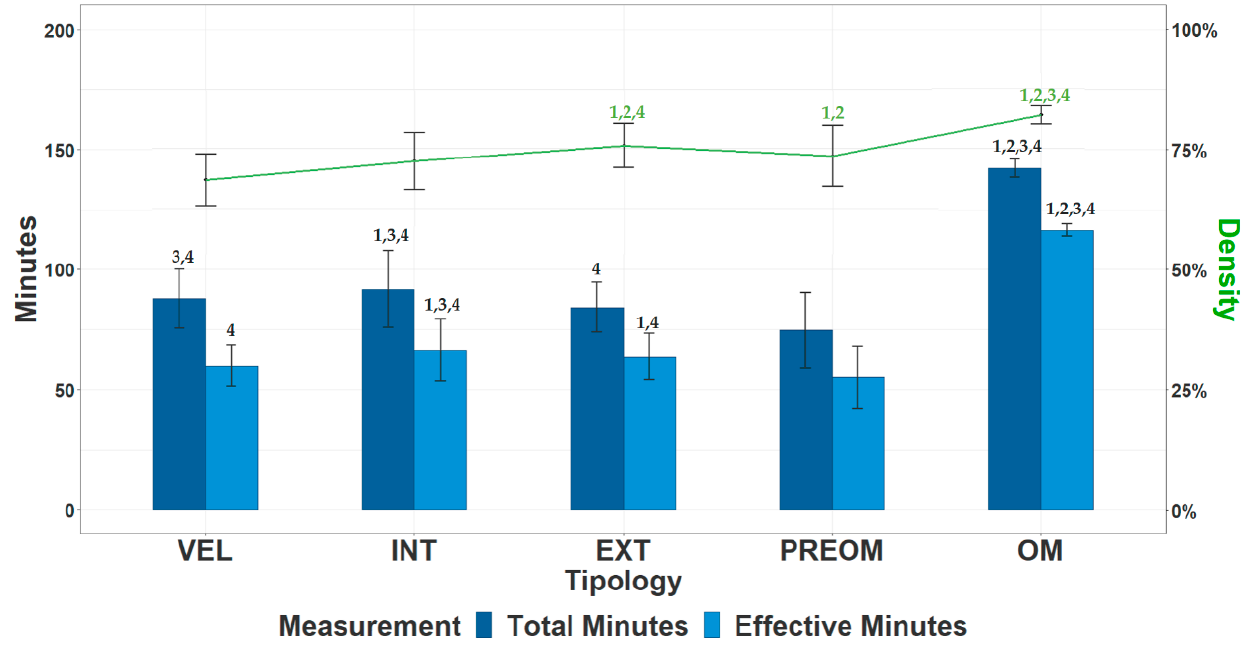
Figure 1. Total duration (min, in dark blue), effective duration (min, in light blue), and density (effective/total, %, in green) of the sessions. Note: VEL is velocity day, INT is intensity or strength day, EXT is extensity or endurance day, PREOM is previous day to match day, OM is official match day. Significant differences ( p < 0.05) are represented: 1 is higher than VEL, 2 is higher than INT, 3 is higher than EXT, and 4 is higher than PREOM.